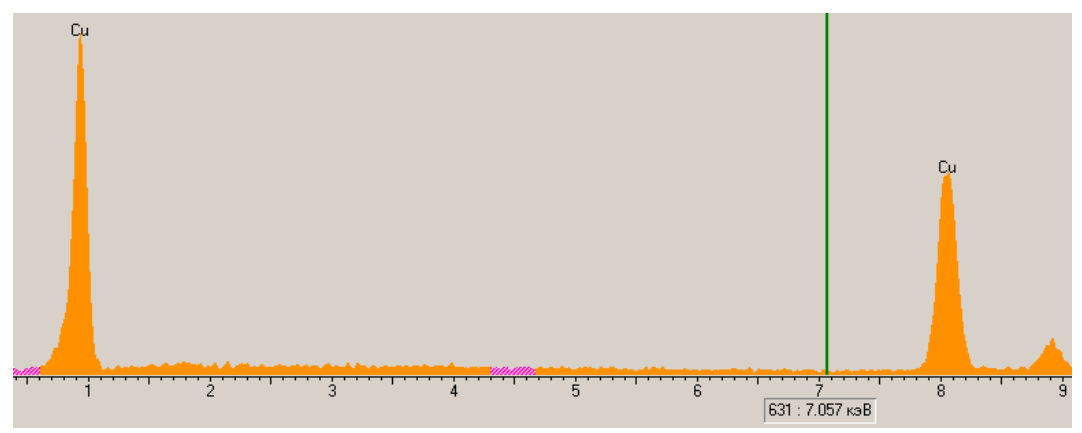
Figure 13. Micrograph of the surface of copper polypropylene obtained in the mode of contrast by the average atomic number (light area-copper).